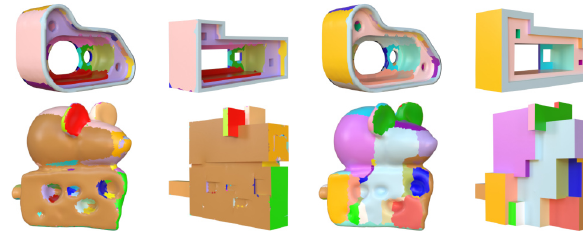
Fig. 8 Polycube deformations with and without polycube topological